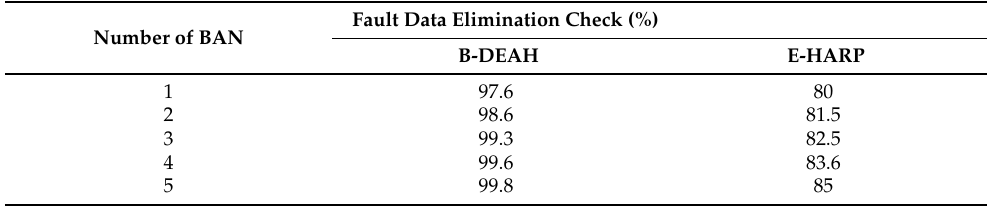
Table 6. Fault data elimination check.